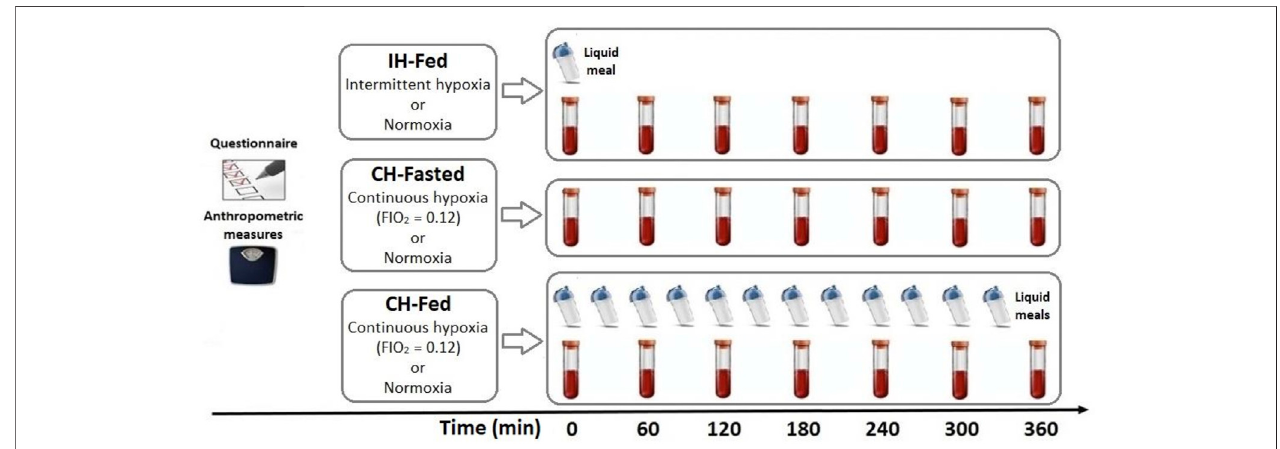
FIGURE1| SchematicsummaryofthethreerandomizedcrossoverstudiesinwhichßOHBconcentrationswereassessedatthetimeindicated.InIH-Fedstudy,14 healthymenwereexposedto6 hofnormoxiaorintermittenthypoxia(15hypoxicevents/hour)followinganisocaloricmeal.IntheCH-Fastedstudy,10healthymenwere exposed to 6 h of continuous normobaric hypoxia (FiO2 = 0.12) or normoxia in the fasting state. In the CH-fed study (CH-Fed), 9 healthy men were exposed to 6 h of normoxia or CH in aconstant Prandial